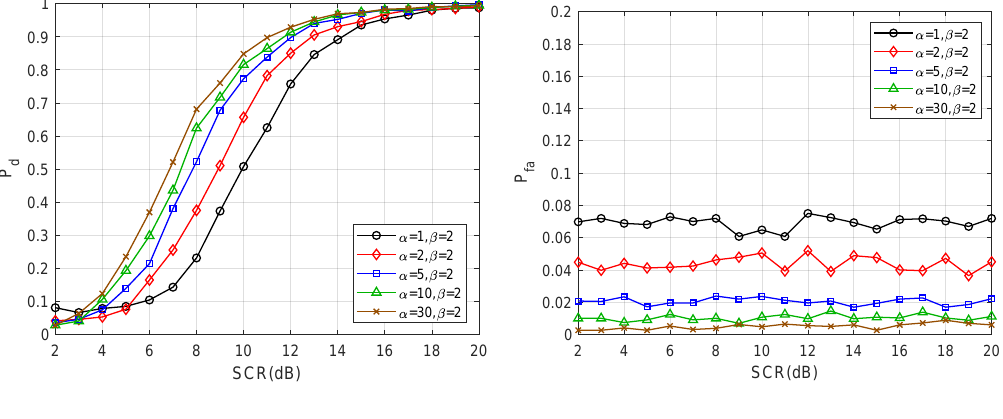
( b ) False-alarm probabilities under different parameters